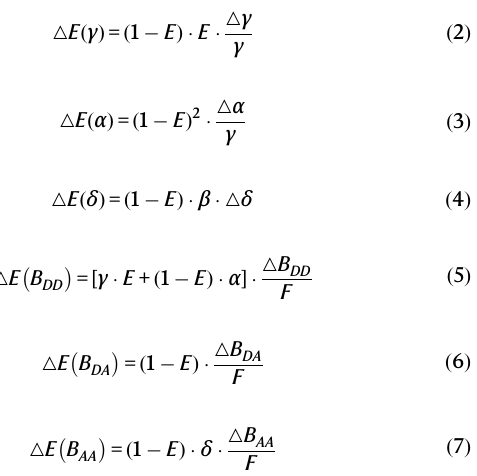
The uncertainty for the experimental FRET ef fi ciency was deter- mined by error propagation of the uncertainties in the correction factors and background counts according to Eq. 1.